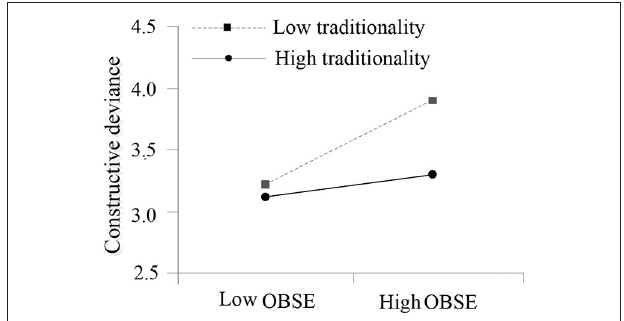
FIGURE 2 | Interaction effect of OBSE and traditionality on constructive deviance.